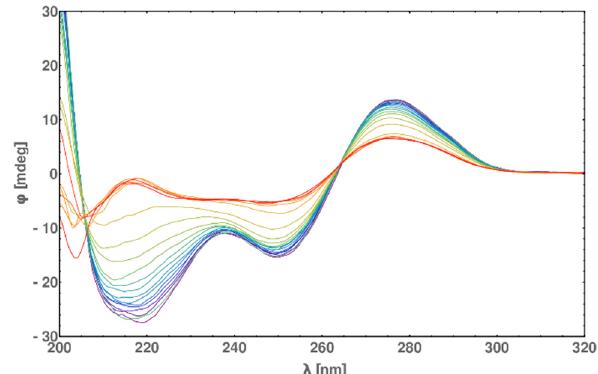
Figure 11. Circular dichroism spectra of dsDNA*-PEP over 0–90 ◦ C temperature range in 5 ◦ C increments from 0 ◦ C (blue) to 90 ◦ C (red). As we can see the melting of the peptide and dsDNA can be seen by the 220 nm ellipticity increasing with the increasing temperature allowing for the determination of melting temperature ~64 ◦ C of the α -helix. Studies of the melting of dsDNA alone can be predicted by monitoring the 280 nm ellipticity—thus we can see the cooperativity of the DNA and peptide melting process.